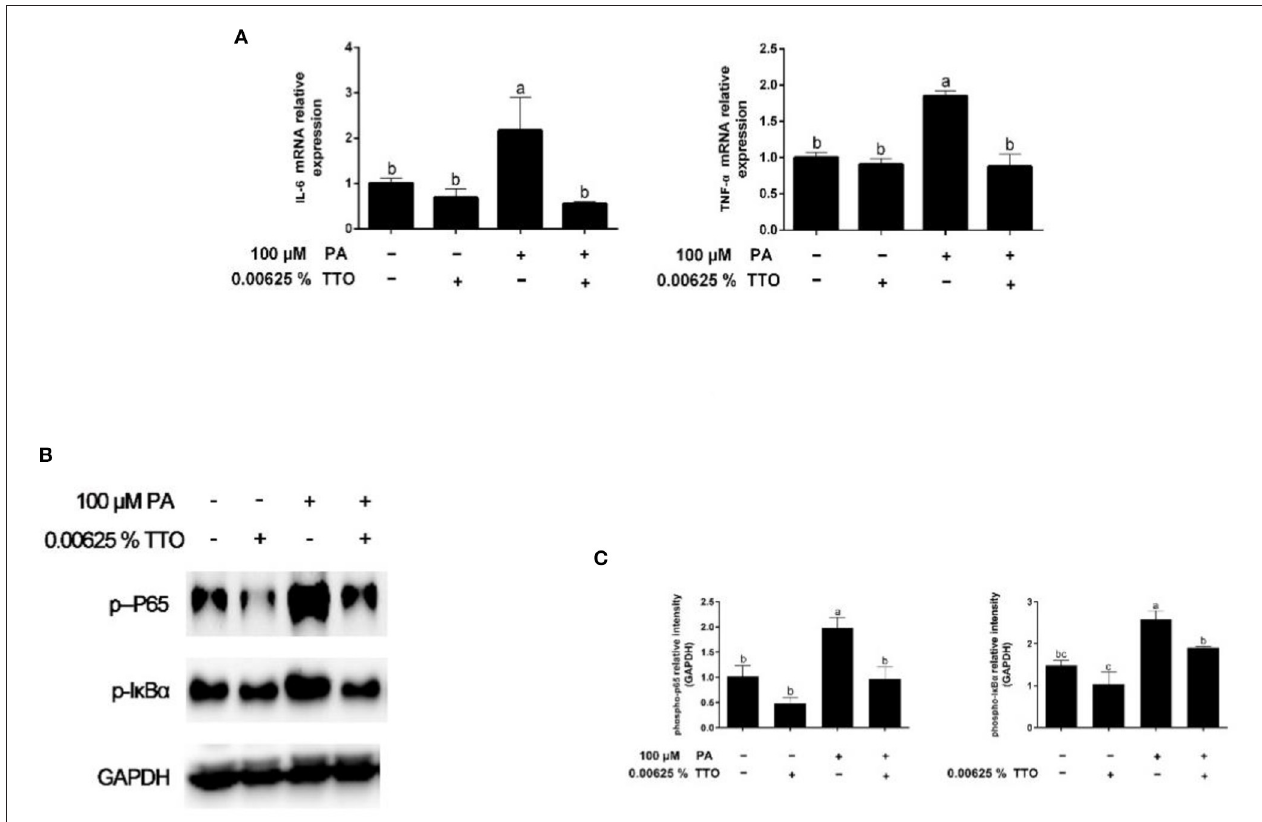
FIGURE 4 | Expression of genes and proteins related to inflammation in bovine hepatocytes treated with TTO (0.00625%) and/or PA (100 µ M). (A) Expression of genes related to inflammatory response, normalized by GAPDH. (B,C) Immunoblots and corresponding intensities of the bands. Protein expression was normalized by the respective abundance of GAPDH. All results are expressed as the mean ± SEM. The letters above the error bars indicate that the differences between groups was significant ( P < 0.05). These data are representative of three independent